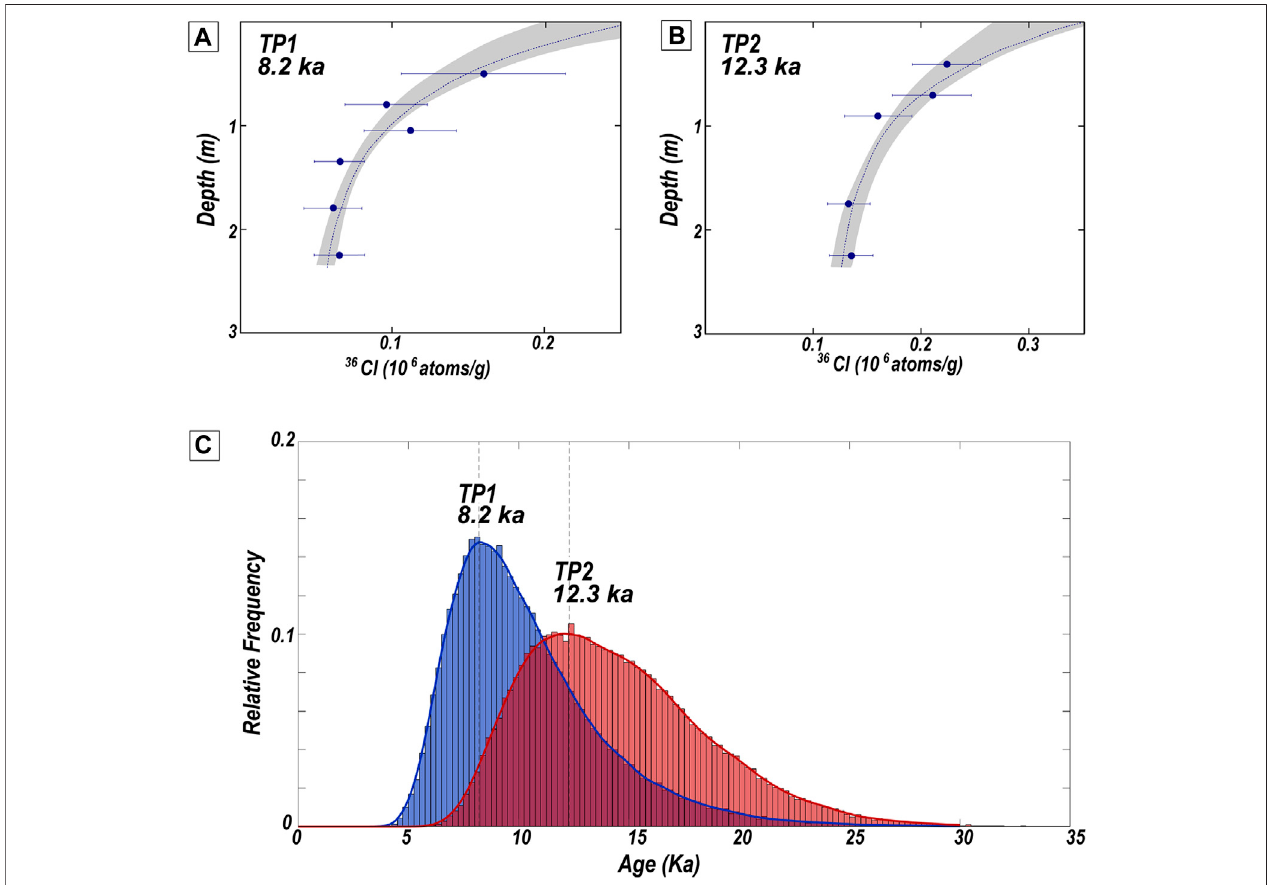
FIGURE 6 | 36 Cl nuclide concentration vs. pro fi le depth for the two sample pro fi les TP1 (A) and TP2 (B) Pro fi le locations shown as yellow stars in Figure 3A . – spaces. Symbols in (a) and (b): black lines - error bars, grey areas – solution space from Monte-Carlo simulations, dashed curved lines – best- fi t age, (C) Probability Density Plots (PDPs) and histograms (n = 10 6 ) of the two depth pro fi les showing exposure ages for terraces T1 and T2. Symbols for (C) : grey dotted line - mode of the asymmetric right-skewed (nonnon-Gaussian) distributions.